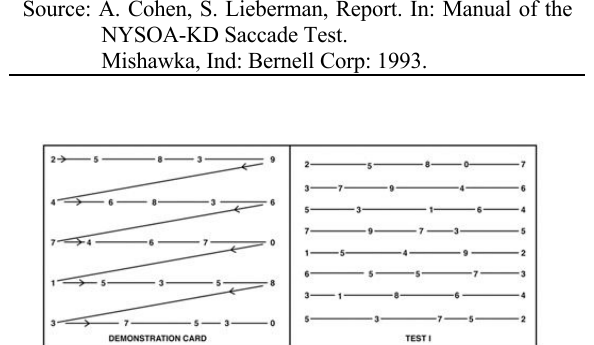
Figure 2. Schematic diagram of an optical see-through display